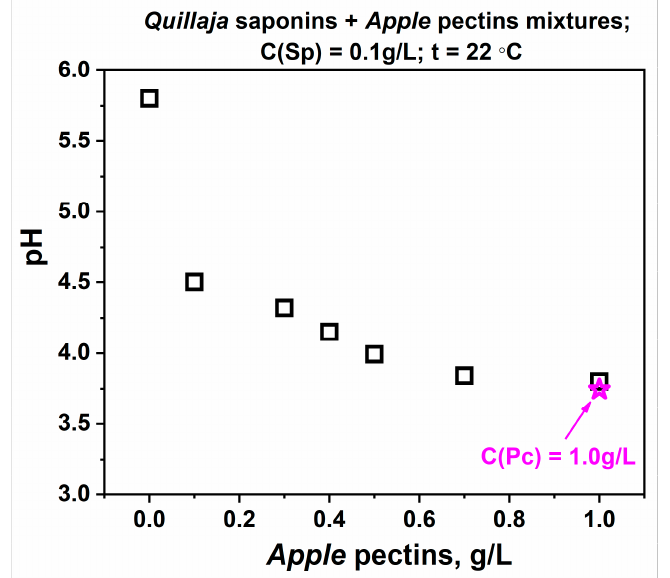
Figure 9. pH of Quillaja saponin and Apple pectin mixture solutions at constant saponin concentration (C(Sp) = 0.1 g/L) vs. various pectin concentrations. The pH value of the Apple pectin-only solution at C(Pc) = 1.0 g/L is also presented.